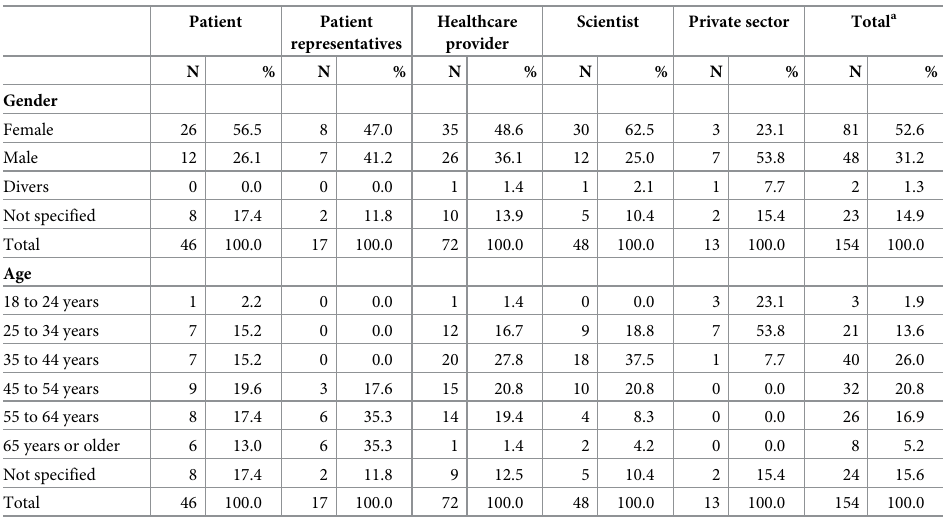
Table 1. Characteristics of the sample.